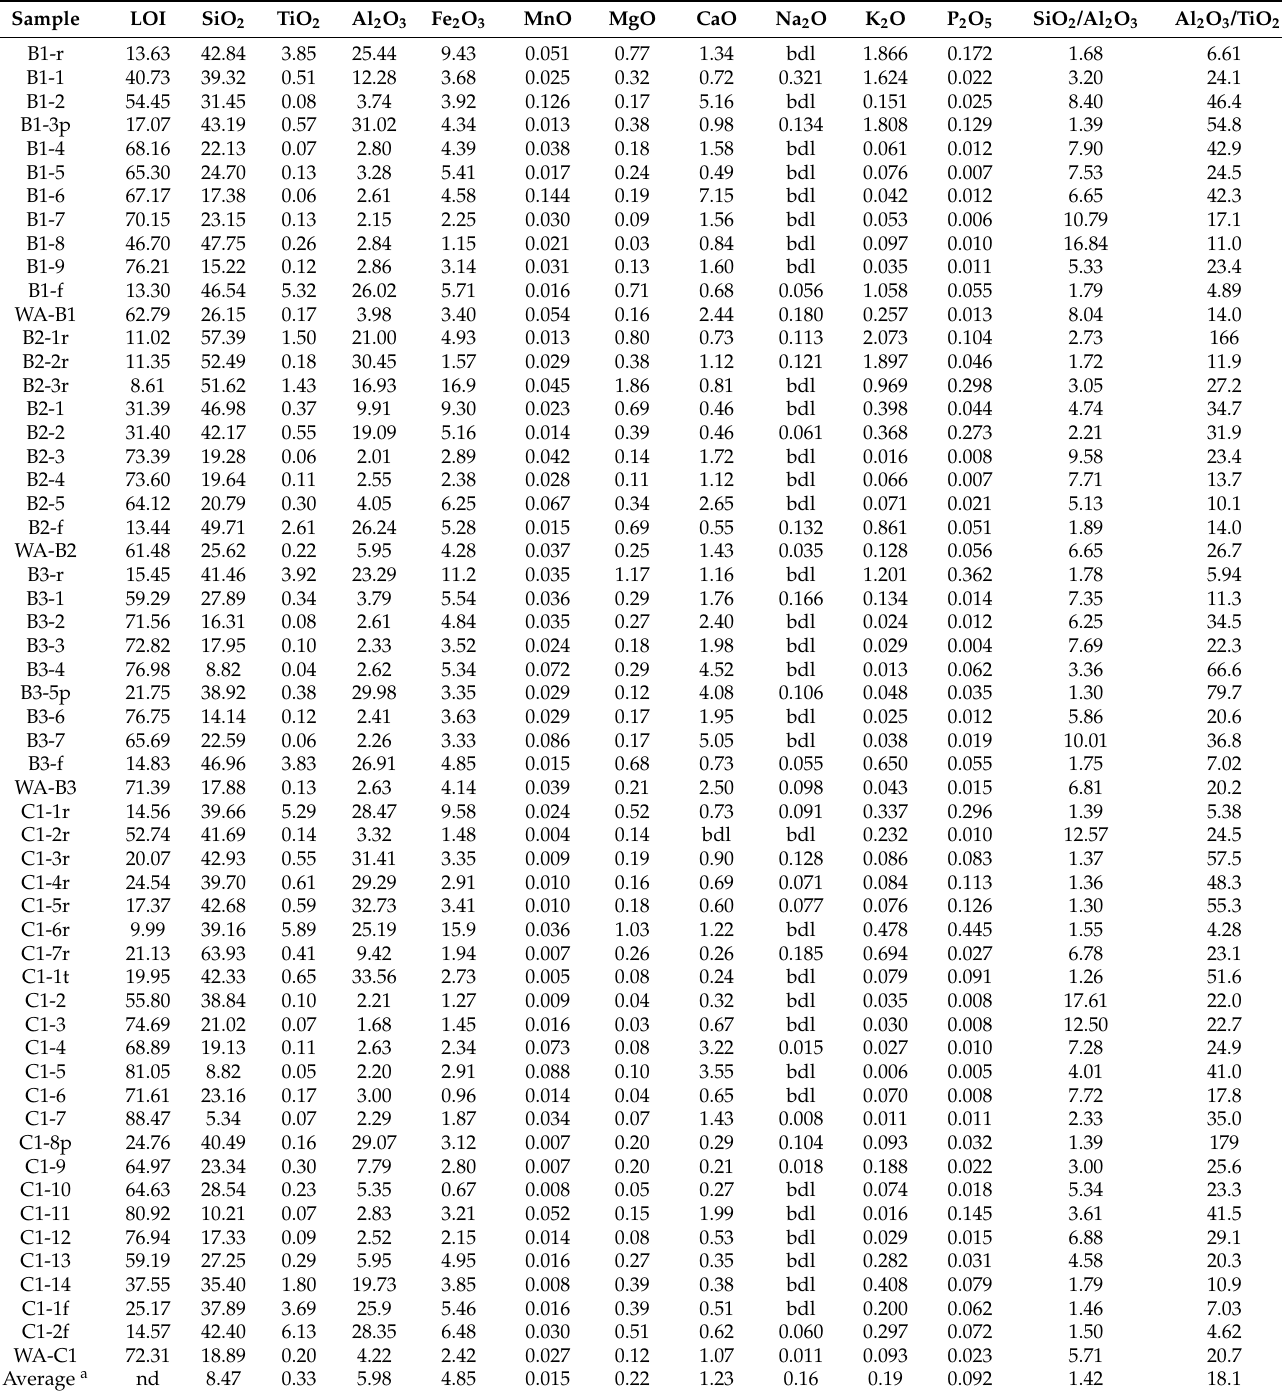
Table 3. Major-element oxides and loss on ignition of coal benches, roof, and floor strata samples, and partings from B1, B2, B3, and C1 coals. (%, on whole coal/rock